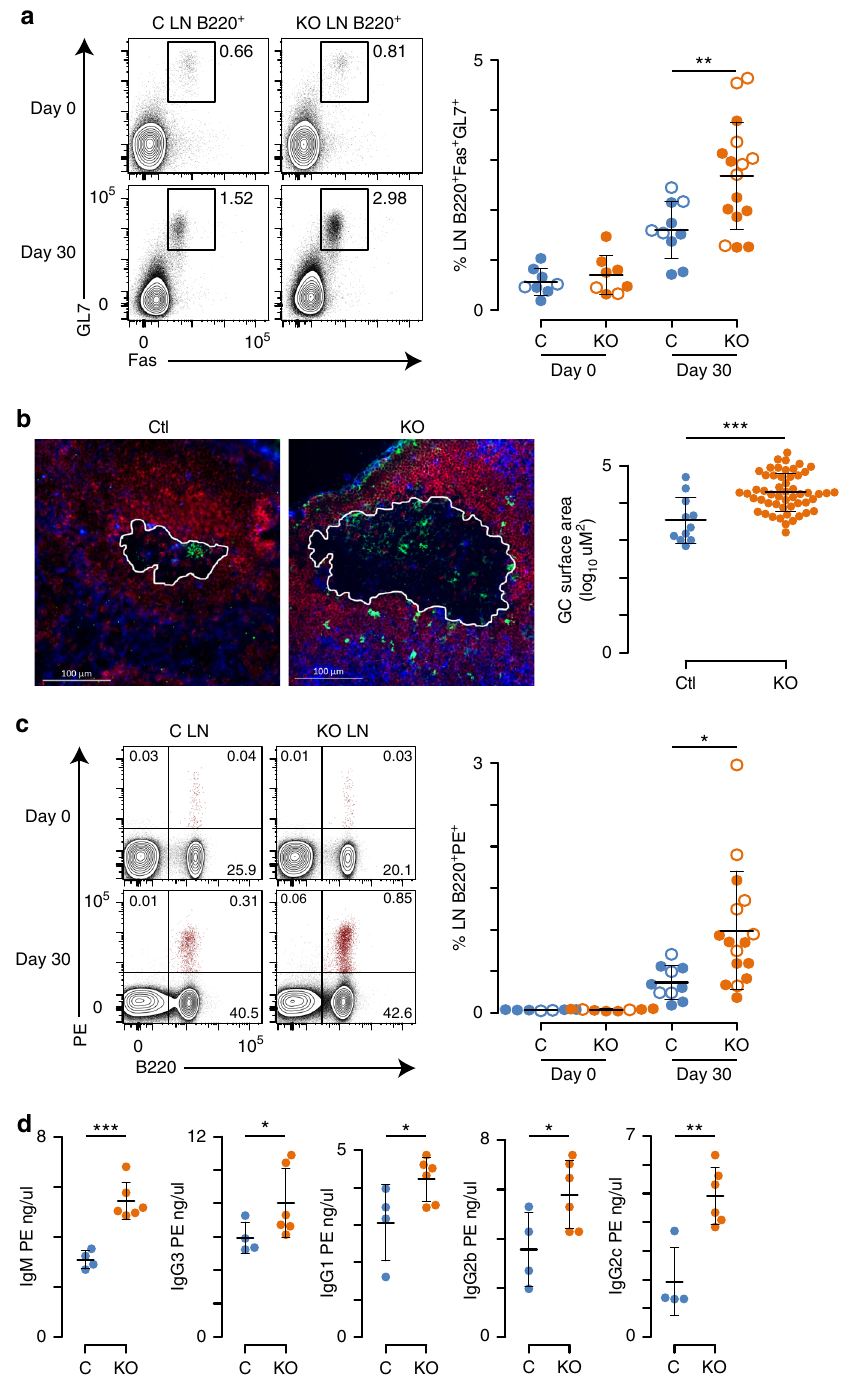
Fig. 1 Increased germinal center B cell expansion in Dnmt3-de fi cient mice. a Germinal centers identi fi ed using Fas and GL7 expression on inguinal and periaortic lymph node (LN) B220 + B cells in naive mice (day 0) and PE-CFA immunized mice (day 30) in Cd19 cre/ + Dnmt3a fl / fl Dnmt3b fl / fl mice (KO) and littermate controls (C). b Immuno fl uorescence of lymph nodes 30 days after PE-CFA immunization showing T cells (blue; Thy1.2), IgD B cells (red; IgD), and activated B cells (green; GL7). The germinal center area is outlined in white and a 100 μ M scale is shown (bottom left). Quantitation of germinal center area is shown (right). c B220 expression and PE-binding of LN lymphocytes from naive mice (day 0) and PE-CFA immunized mice (day 30). Flow cytometry data are lymphocyte size gated and CD11b − . d Serum PE-speci fi c antibodies for C and KO mice 30 days post-immunization. Mean and standard deviation shown on beeswarm plots and P values are calculated using a two-sided t -test (* P < 0.05, ** P < 0.01, *** P < 0.001). Data are from either two, day 0 experiments with eight mice each and two, day 30 experiments with 9 mice and 17 mice ( a , c ) or from one, day 30 experiment with 10 mice ( b , d ), where open circles represent females and closed circles males and no sex differences were observed in multivariate